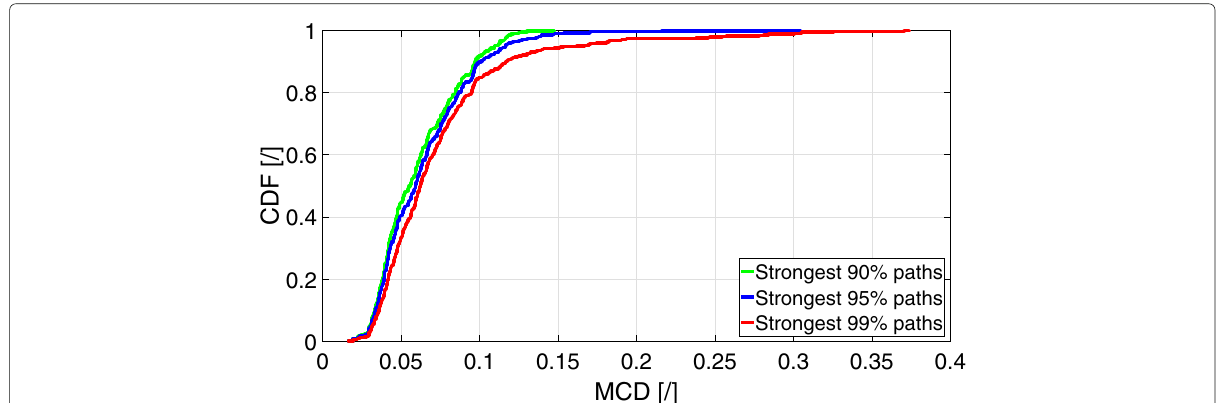
Fig. 4 CDF of the MCD metrics between the input and output strongest 90, 95, and 99% propagation